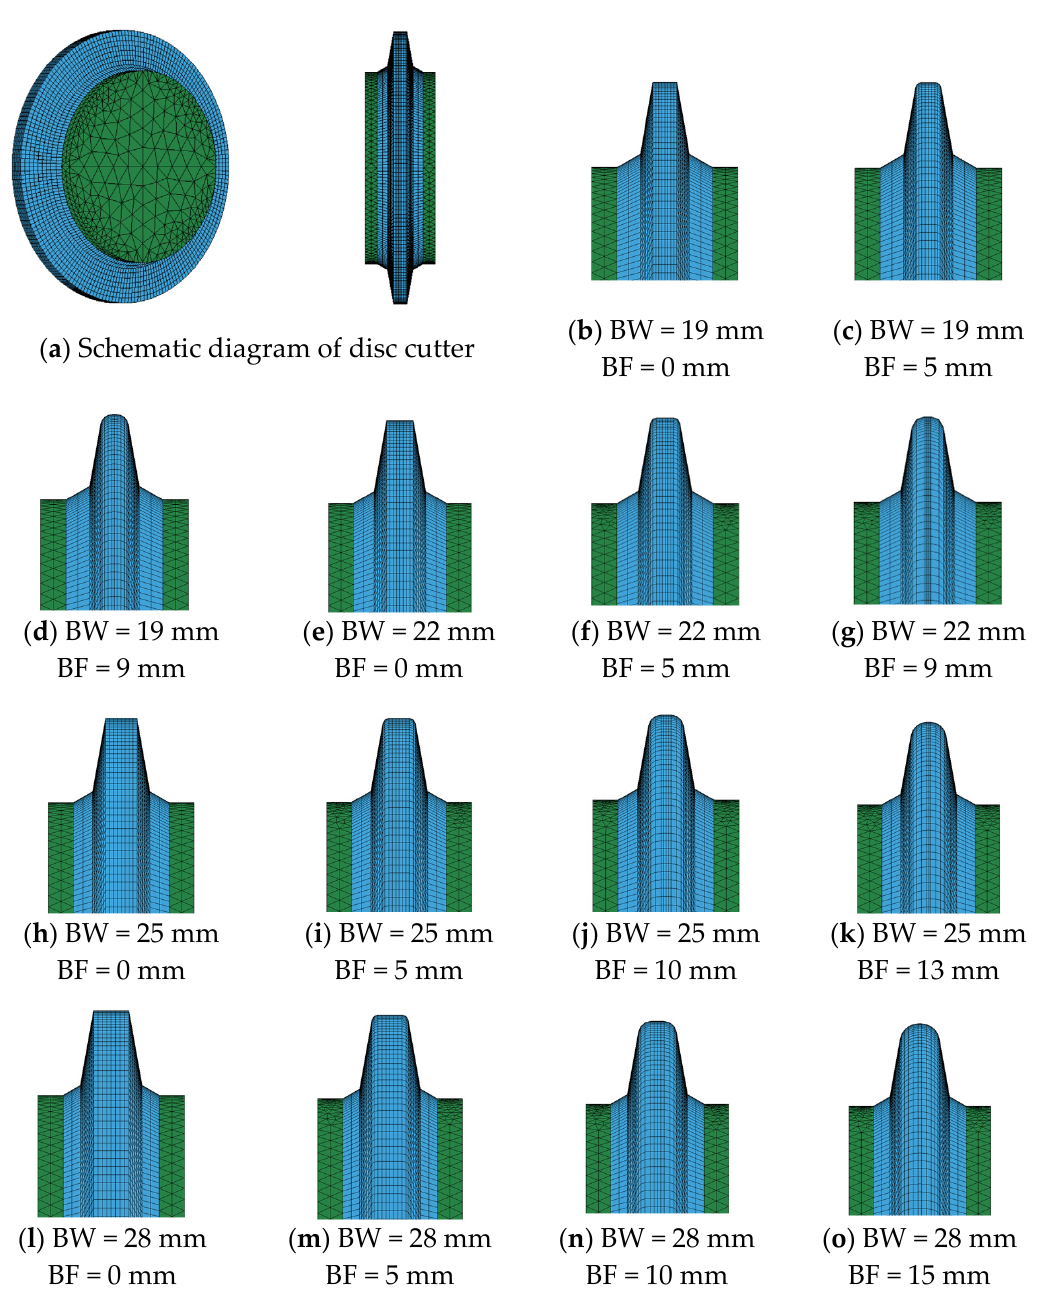
Figure 13. Load RCFORCE into the model. Figure 14. Plot the contact force.